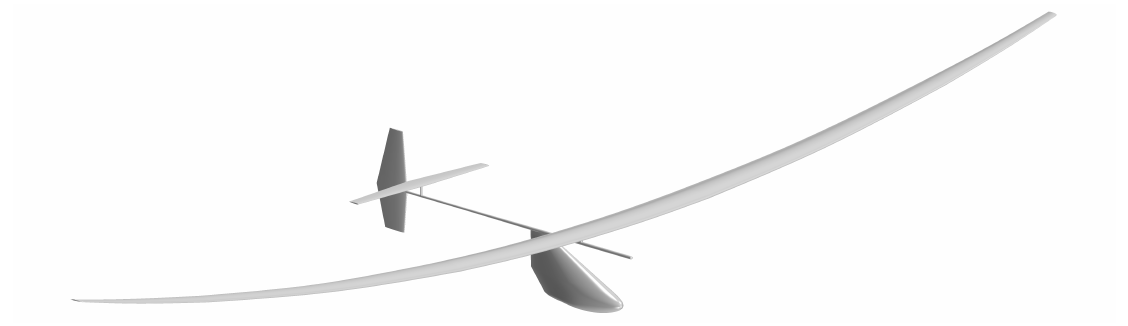
Figure 3. CAD model of the